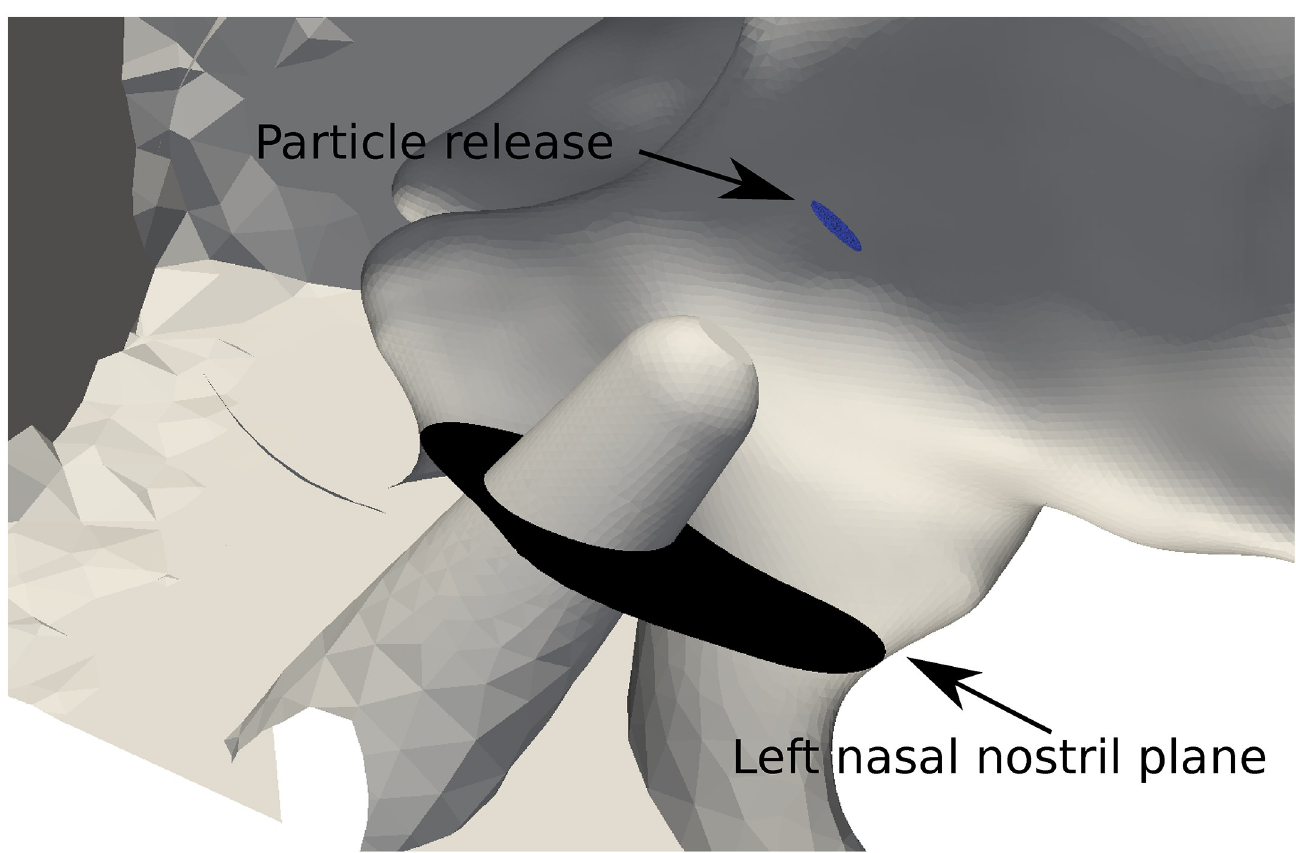
Fig 5. Spray insertion into nasal cavity, showing relative distances. Particles released from a break-up distance downstream from the spray nozzle.